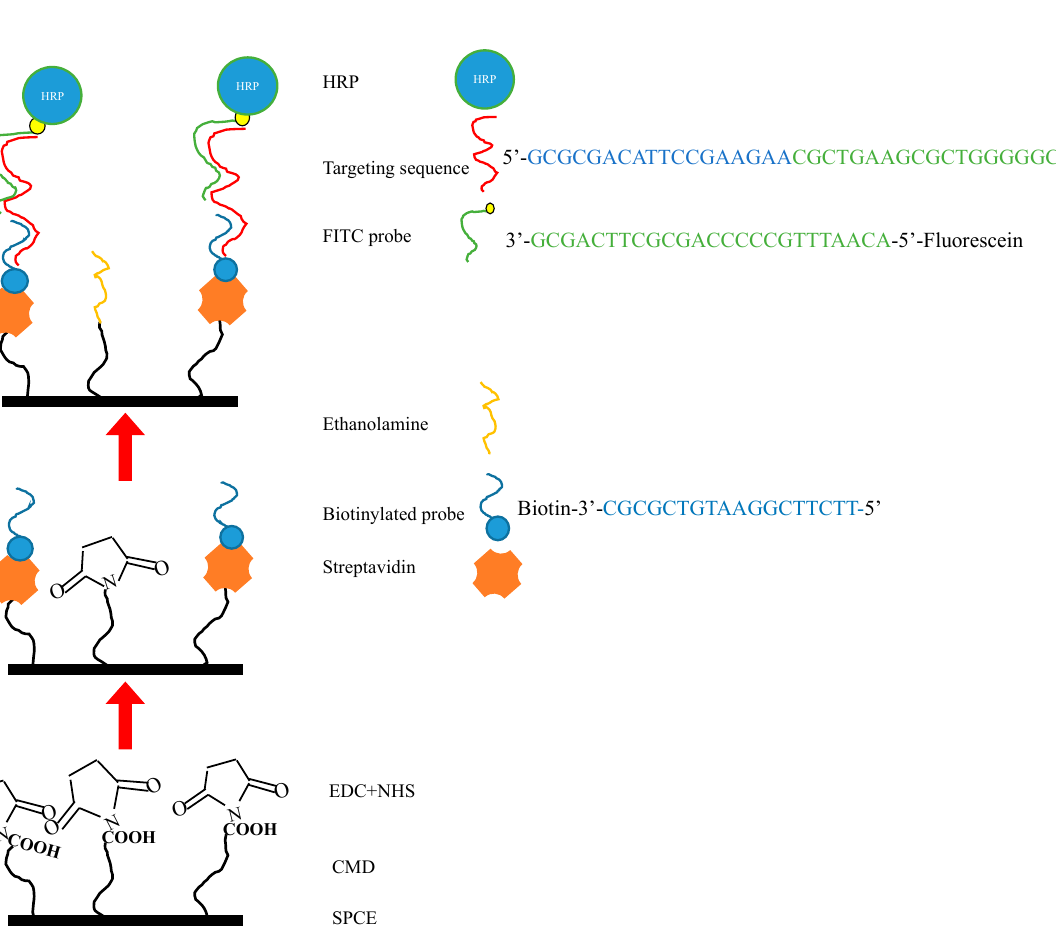
Figure 1. Establishment of the SARS-CoV-2 biosensor using the modified screen-printed carbon electrode (SPCE) and probe design. CMD was used to modify the SPCE to provide the reactive groups, followed by EDC and NHS crosslinking to the electrode. Streptavidin was subsequently added to the electrode. After this, the biotinylated probe was immobilized onto streptavidin, with ethanolamine occupying the remaining SPCE surface. In order to detect the mimicked targeting sequence, pretreatment of RNA and the fluorescein-modified detection probe (FITC probe) was conducted in a separate medium. The addition of the targeting sequence/FITC probe complex to the functional SPCE surface allowed for hybridization. With the addition of anti-fluorescein horseradish peroxidase (HRP), a catalyzed redox reaction occurs between tetramethylbenzidine (TMB) and H 2 O 2 at the surface of the electrode.